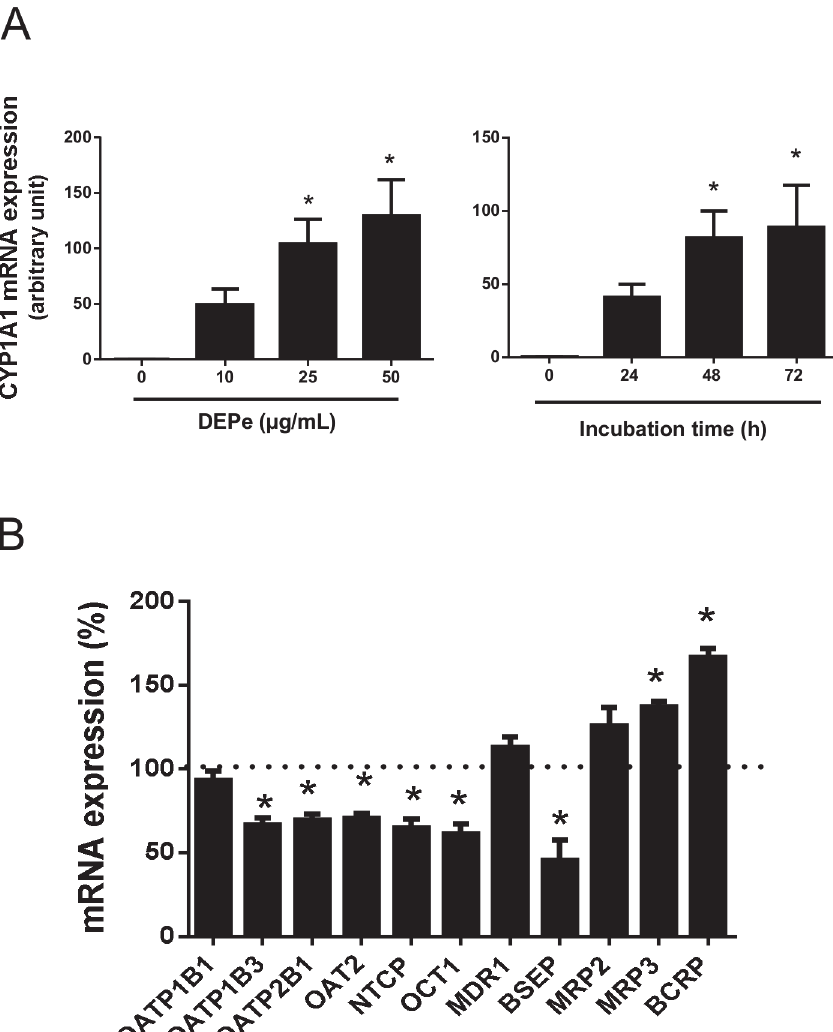
Fig 5. Regulation of drug transporter mRNA expression by DEPe. (A) Human highly-differentiated HepaRG cells were either untreated or exposed to various concentrations of DEPe for 48 h (right panel) or to 25 μ g/mL DEPe for various exposure time (left panel). CYP1A1 mRNA expression was analysed by RT- qPCR. Data are expressed in arbitrary units relative to 18S RNA content and are the means ± SEM of three independent assays. * , p < 0.05 when compared to control cells (ANOVA followed by a Dunnett ’ s post-hoc test). (B) HepaRG cells were either untreated or exposed to 25 μ g/mL DEPe for 48 h. Drug transporter mRNA expression was evaluated by RT-qPCR. Data are expressed as % of transporter expression found in control untreated cells, arbitrary set at 100% and indicated by a dotted line; they are the means ± SEM of three independent assays. * , p < 0.05 when compared to control cells (ANOVA followed by a Dunnett ’ s post-hoc